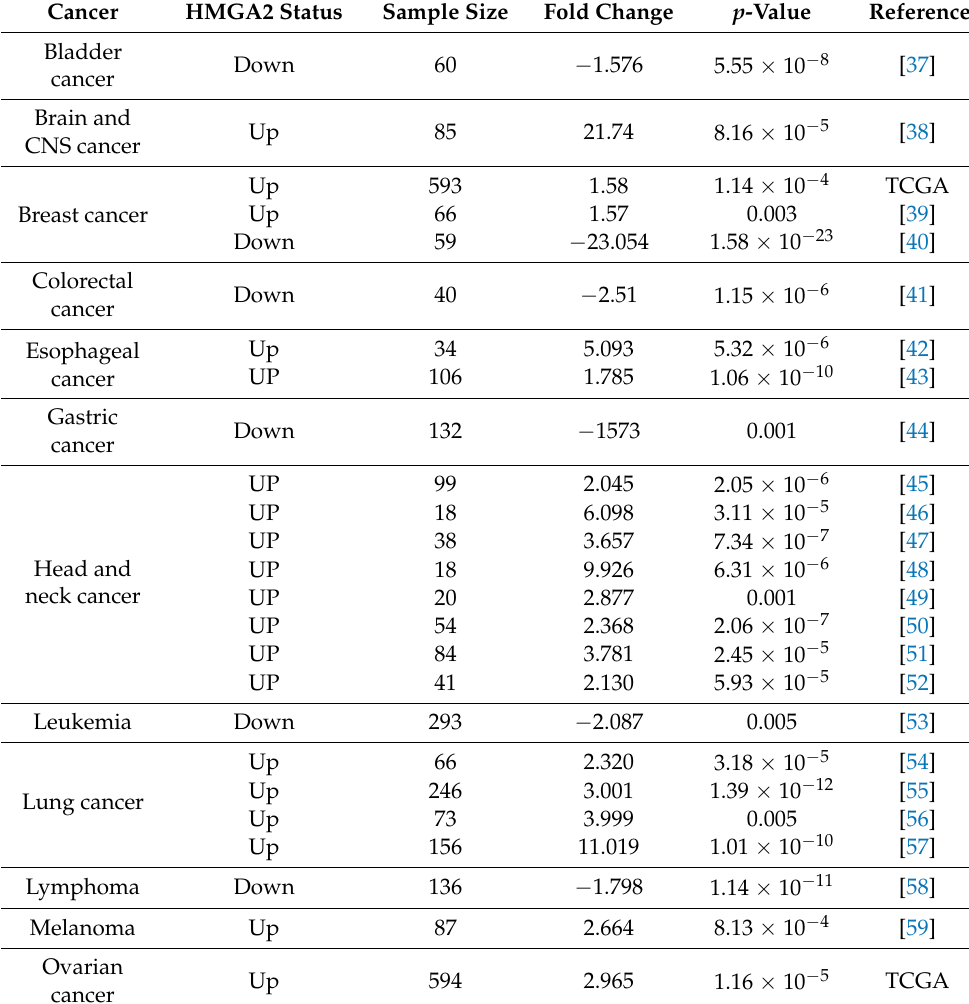
Table 1. HMGA2 expression changes in different cancer types. Data compare cancer tissues to normal tissues. The cut-offs including p -value = 0.01, fold change = 1.5, and gene ranking =